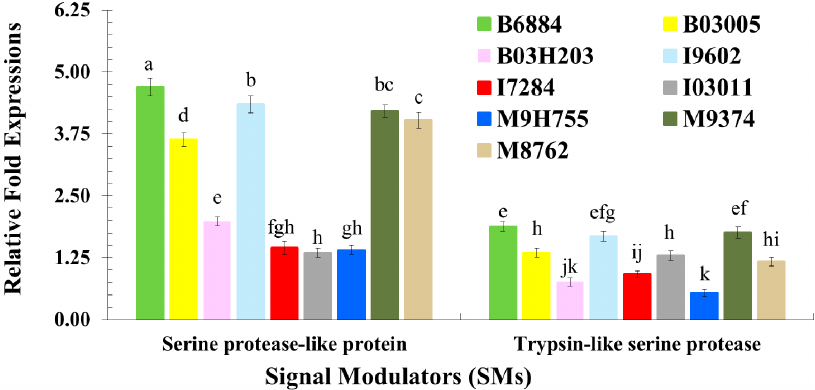
Figure 3. Relative fold-expression of signal modulators of Rhynchophorus ferrugineus larvae in response to fungal infections using quantitative real-time PCR. Means ± SE values followed by different letter(s) are significantly different. (Fisher’s Least Significant Difference (LSD) test, α = 0.05).